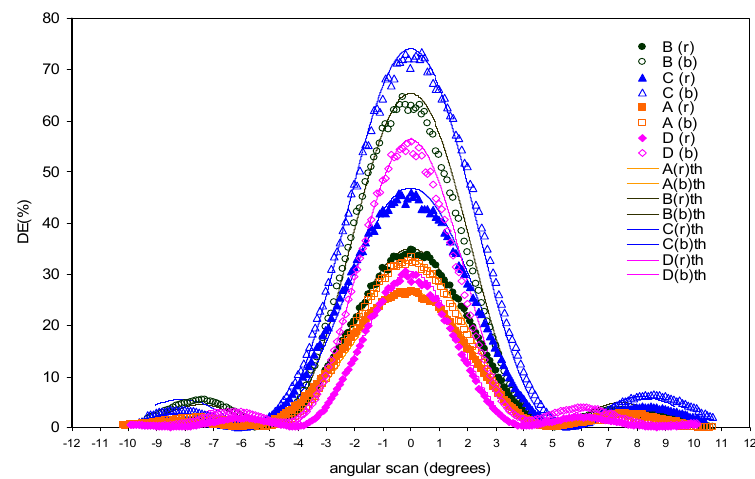
Figure 5. Experimental diffraction efficiency (DE) versus angular scan for photopolymers after recording: A(r), B(r), C(r), D(r), and after bleaching: A(b), B(b), C(b), D(b). The solid lines: A(r)th, B(r)th, C(r)th, D(r)th, and A(b)th, B(b)th, C(b)th, D(b)th show the theoretical fitting after recording and after bleaching, respectively.